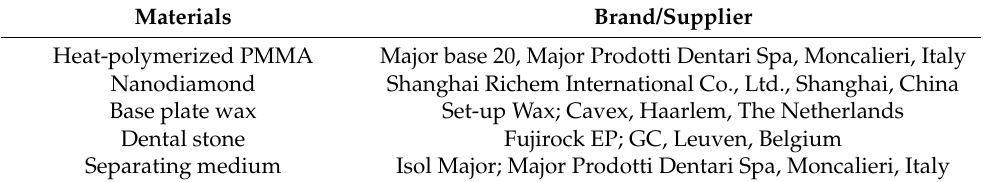
Table 1. Materials